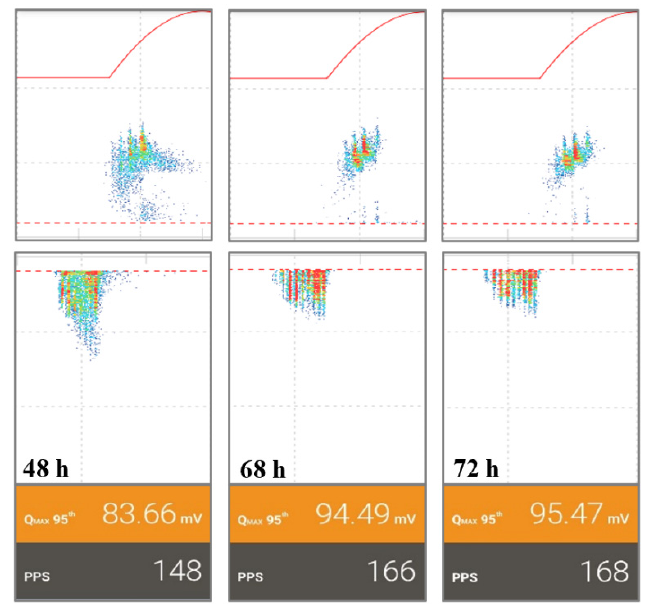
Figure 10. DCP voltage PRPD patterns with δ = 0.6, acquired after 48, 68 and 72 h of voltage application. To save space compared to Figure 8, the PRPD patterns positioned in the upper part are obtained during the DCP rising time, while those in the bottom part refer to the DCP falling time.